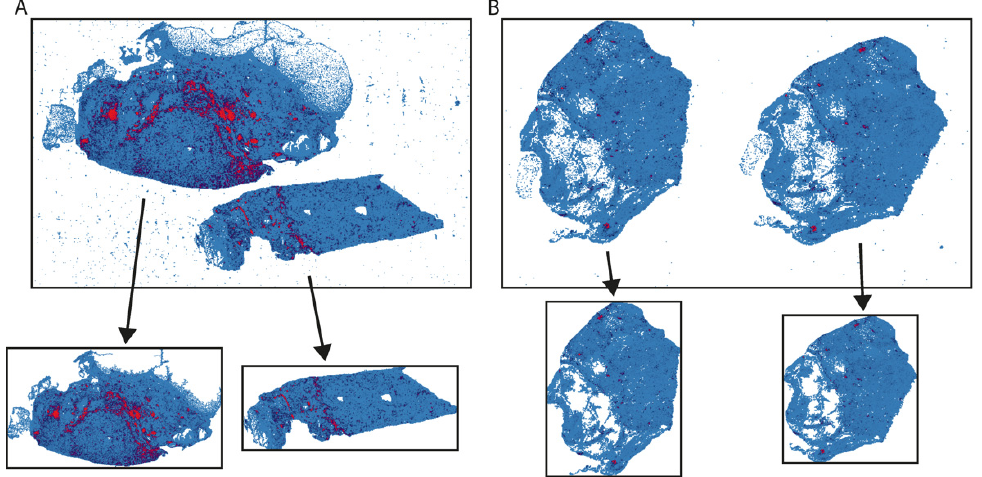
Figure 1. Example of TIL maps representing images consisting of two different tissue fragments present on the same slide ( A ) or two adjacent slices of the same tissue fragment ( B ). Top rows show original TIL maps, while bottom rows are regions of interest (ROIs) that were provided after data preprocessing.